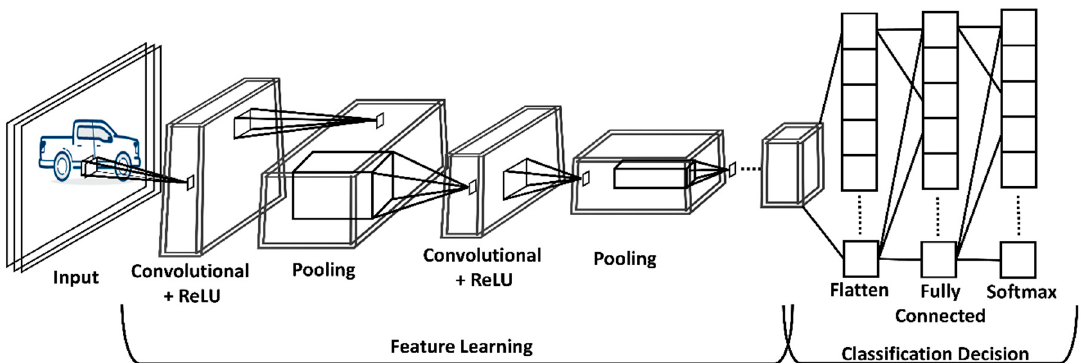
Figure 2. Convolutional Neural Networks (CNN).